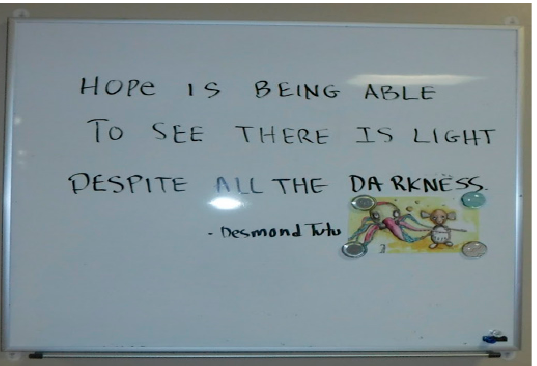
Figure 9. This was a quote that someone wrote that brought inspiration to possibly everyone who passed through that area.